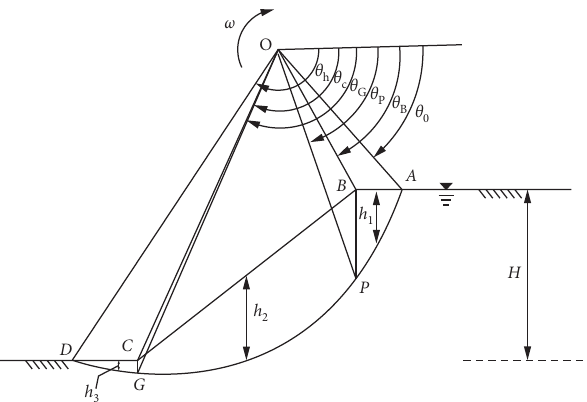
Figure 5: Symmetry plane of base-failure mechanism with ground water.